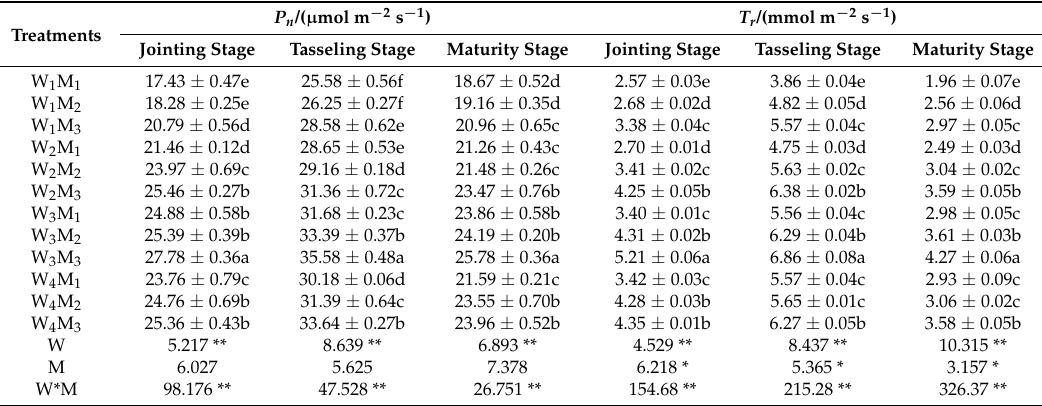
Table 2. Effect of irrigation amount on P n and T r of degradable film-covered drip-irrigated maize.